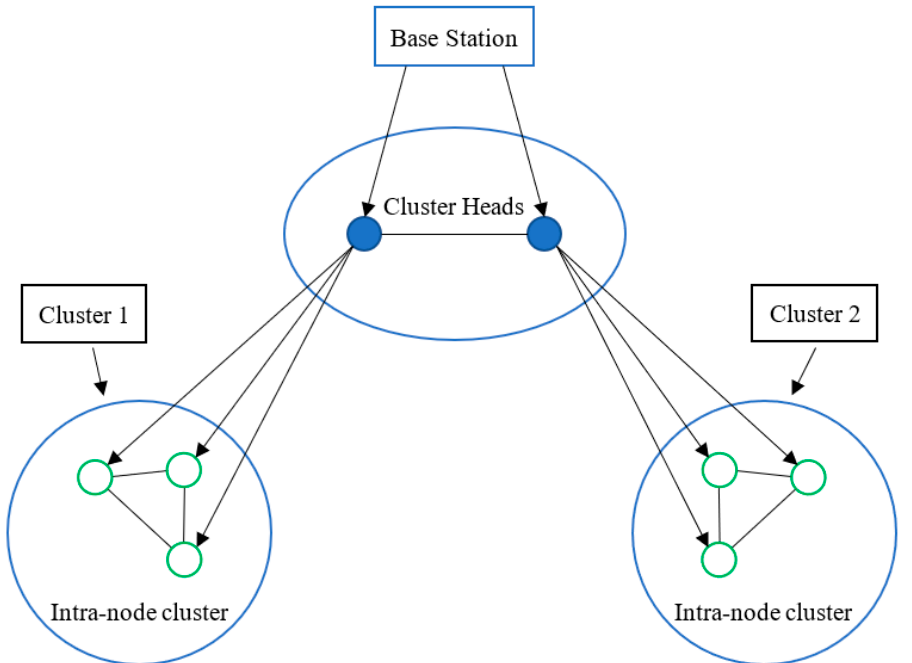
Figure 15. RBS protocol clustering topology.